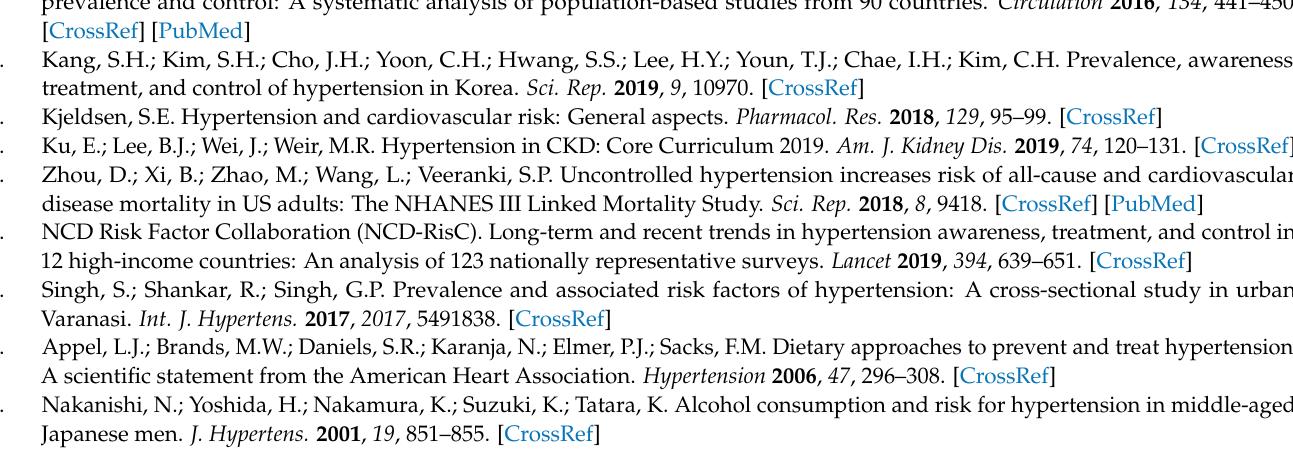
validation dataset (KoGES) by quintiles of hypertension probabilities in Korean men. Table S5. Base- Korean women. Figure S1. Predictors for Korean men selected by NRI method. Figure S2. Predictors for Korean women selected by NRI method. Figure S3. CART analysis flowchart. Figure S4. Variance importance of the sex-specific hypertension classification model measured by CART method. (A) Men (B)